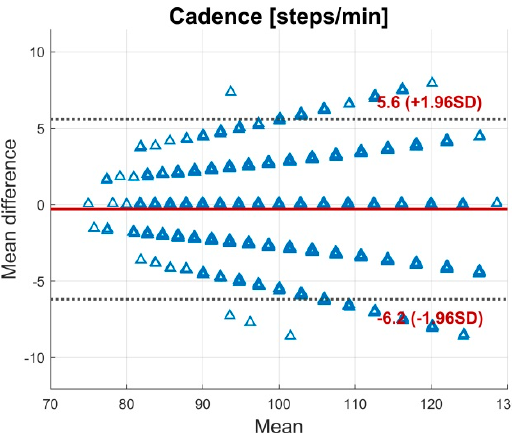
Figure A1. BA plot for the cadence. The plot contains all calculated data points of all subjects. The solid line indicates the mean difference. The dashed lines indicate the LoA (95% CI of the mean difference).